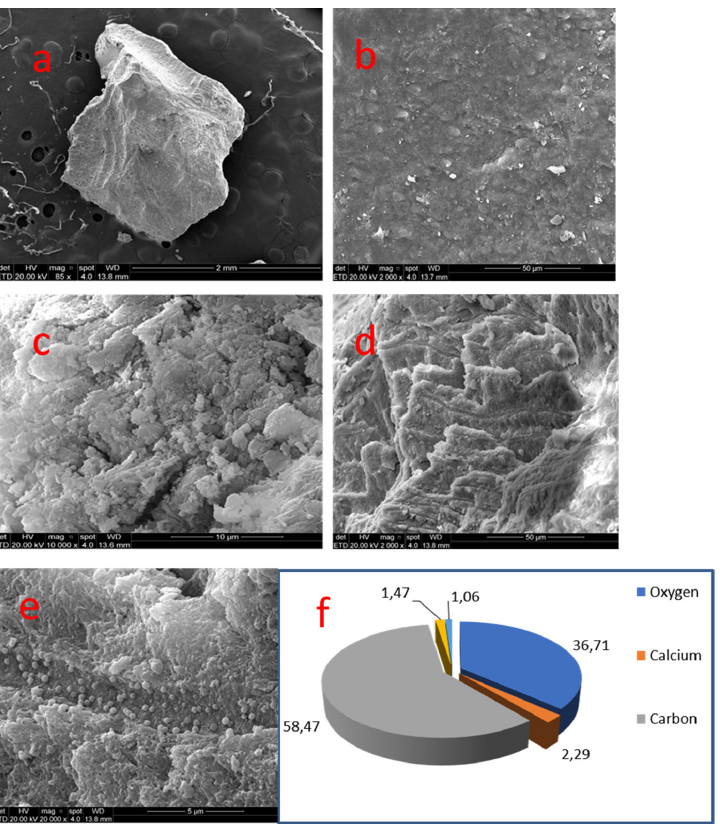
Figure 3. Sample 01: ( a ) Fragment of a coronal nodule (SEM, 85×); ( b ) Smooth and compact surface area (SEM, 2.000×); ( c ) Irregular and porous area (SEM, 10.000×); ( d ) Tubular structures along frag- surface area (SEM, 2000 × ); ( c ) Irregular and porous area (SEM, 10,000 × ); ( d ) Tubular structures mented area (SEM, 2.000×); ( e ) Tubular structures containg calcospherites (SEM, 20.000×); ( f ) Results along fragmented area (SEM, 2000 × ); ( e ) Tubular structures containg calcospherites (SEM, 20,000 × ); of chemical analysis of the sample with X-ray dispersive energy spectroscopy (EDX). ( f ) Results of chemical analysis of the sample with X-ray dispersive energy spectroscopy